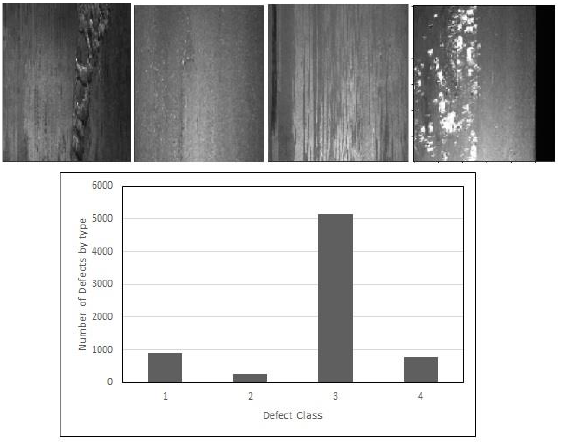
Figure 3. Severstal types of defects.